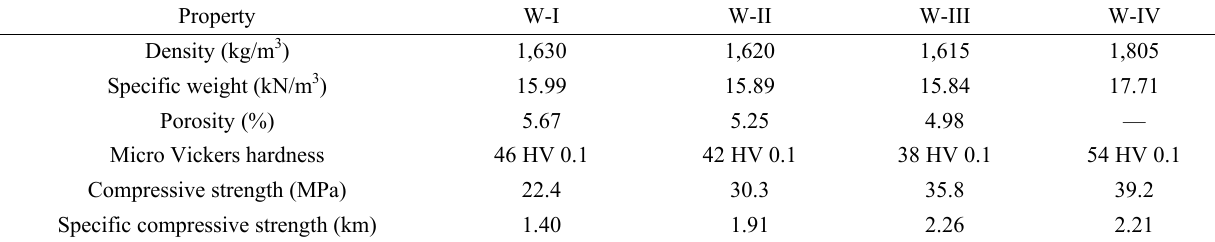
Table 5 Mechanical and physical properties.